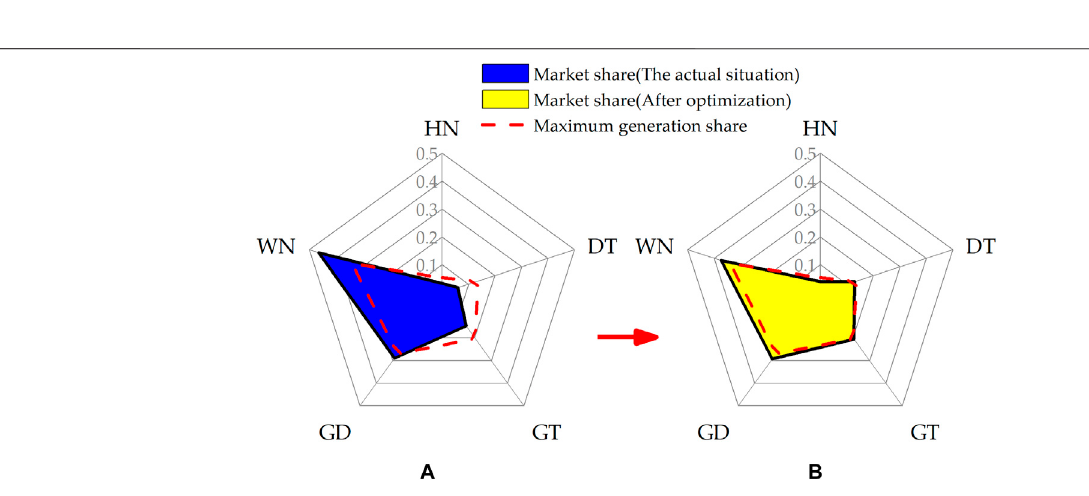
Frontiers in Energy Research |